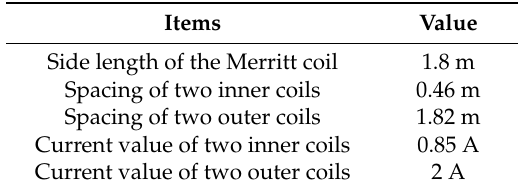
Table 1. Key parameters of Merritt coil.